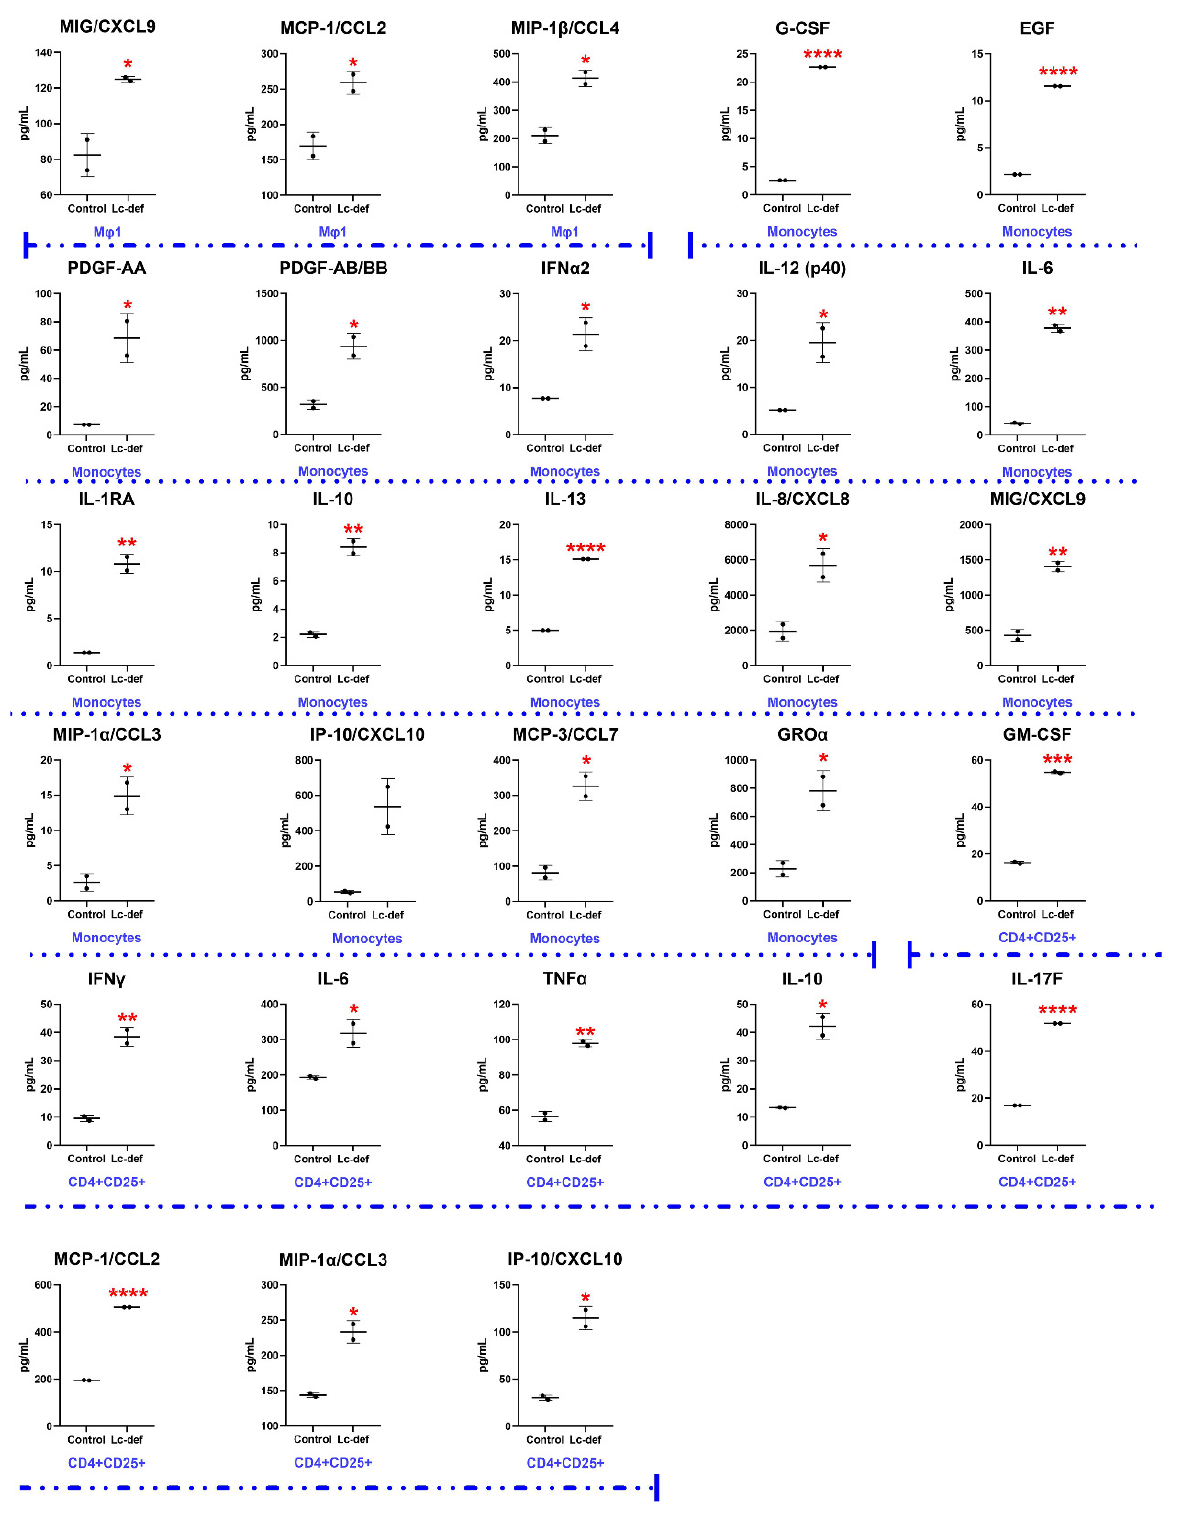
Figure 5. Profiles of cytokines and chemokines production by different cell cultures in vitro in response to Lc-def after incubation with 2 μ M of the peptide. Error bars represent a standard deviation (±SD) between two replications. Significance levels are: * p < 0.05, ** p < 0.01, *** p < 0.0005, **** p < 0.0001.